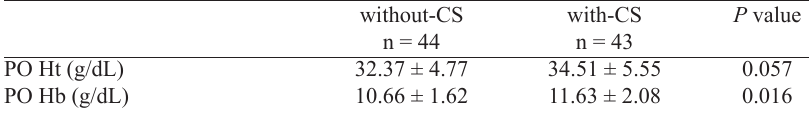
Table 3. Postoperative mean values of hematocrit and hemoglobin in both groups